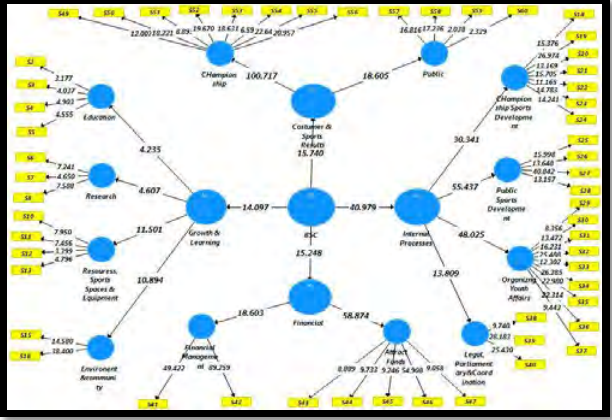
Figure1. The pattern of significant coefficients (z)